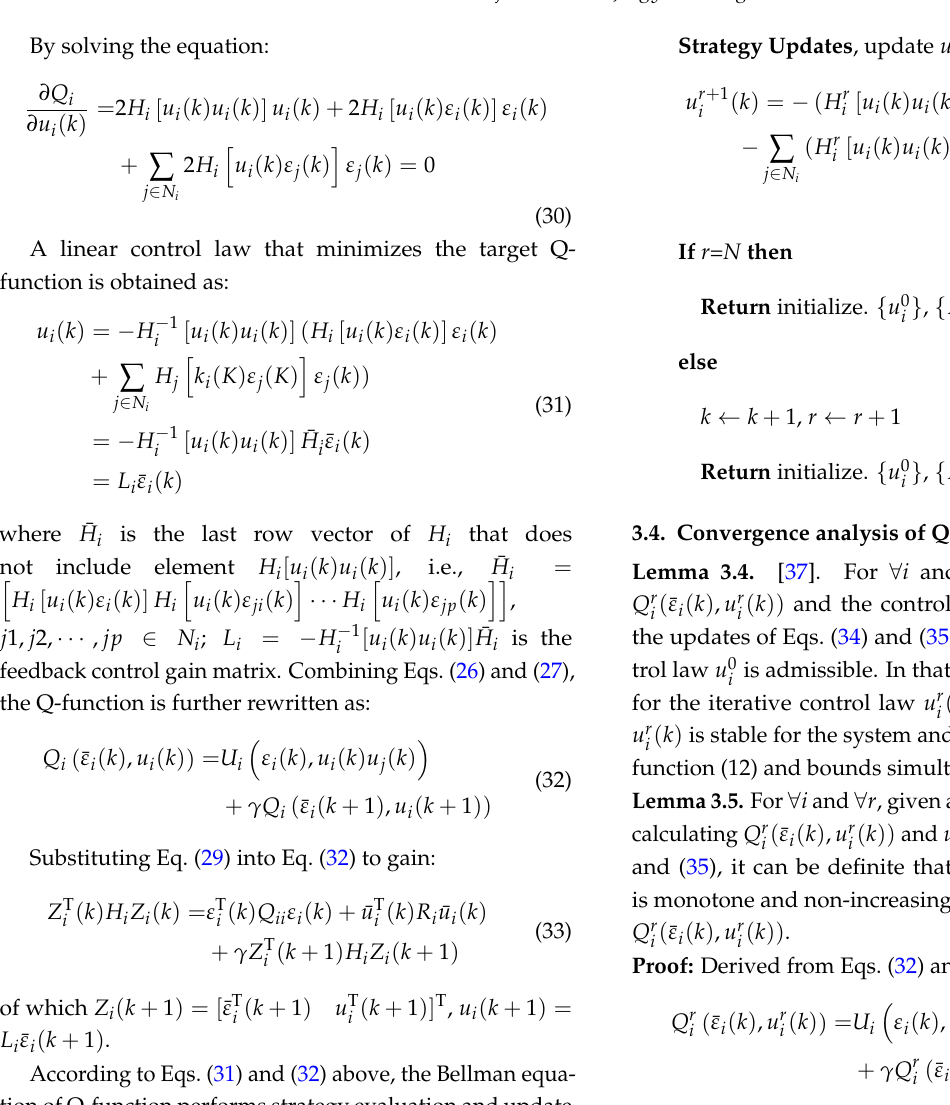
Algorithm 3.1.: Q-learning algorithm for output regulation of multi-agent